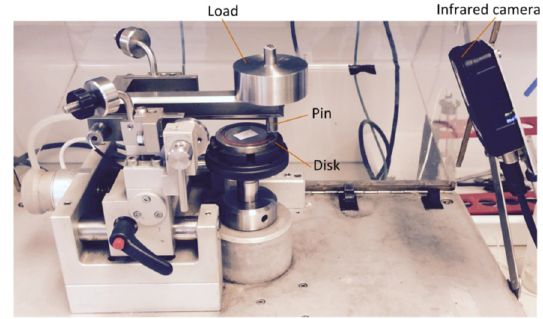
Figure 3. Pin-on-disc apparatus [31].